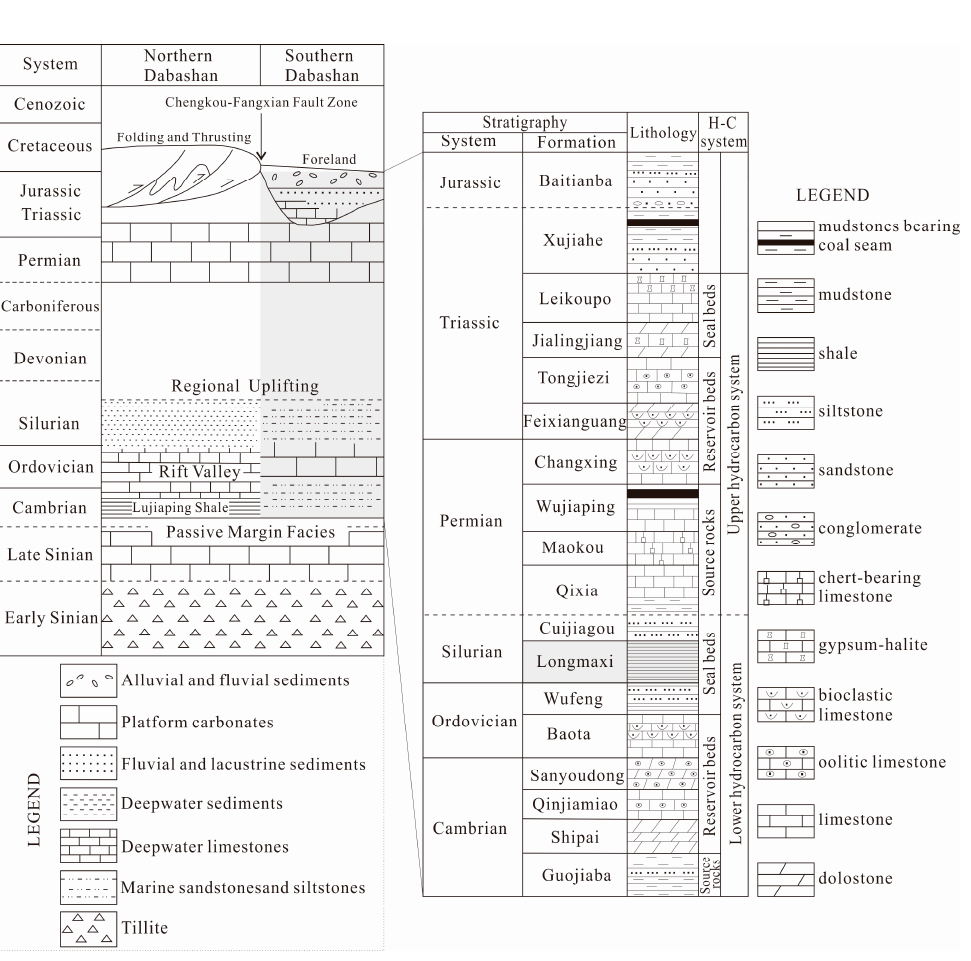
Figure 2. Integrated stratigraphic column of the northeastern Sichuan Basin. H-C is the abbreviation for